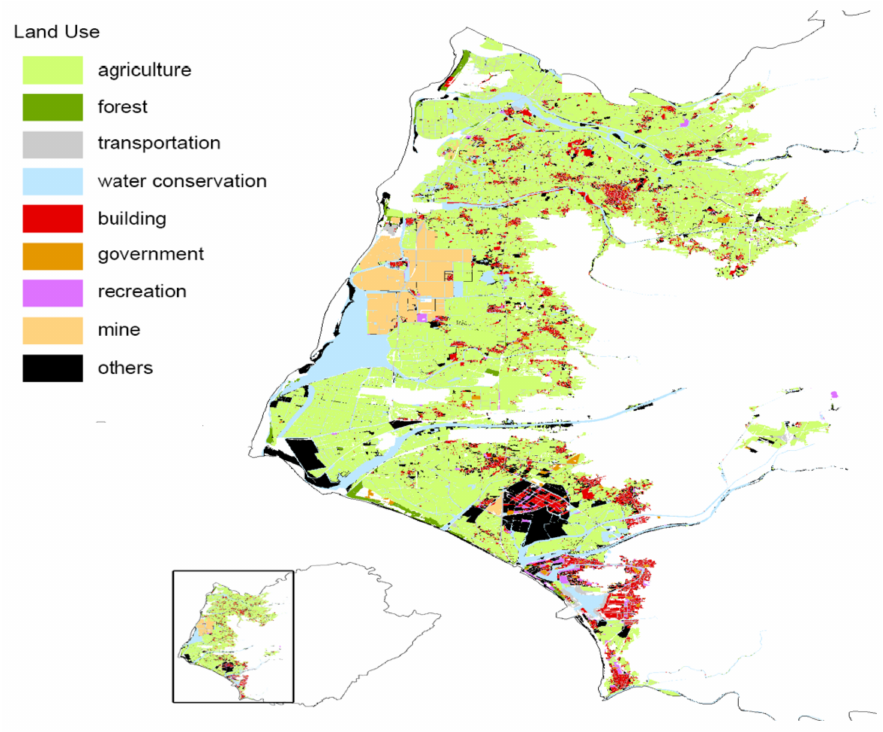
Figure 11. Land use map of inundation area of